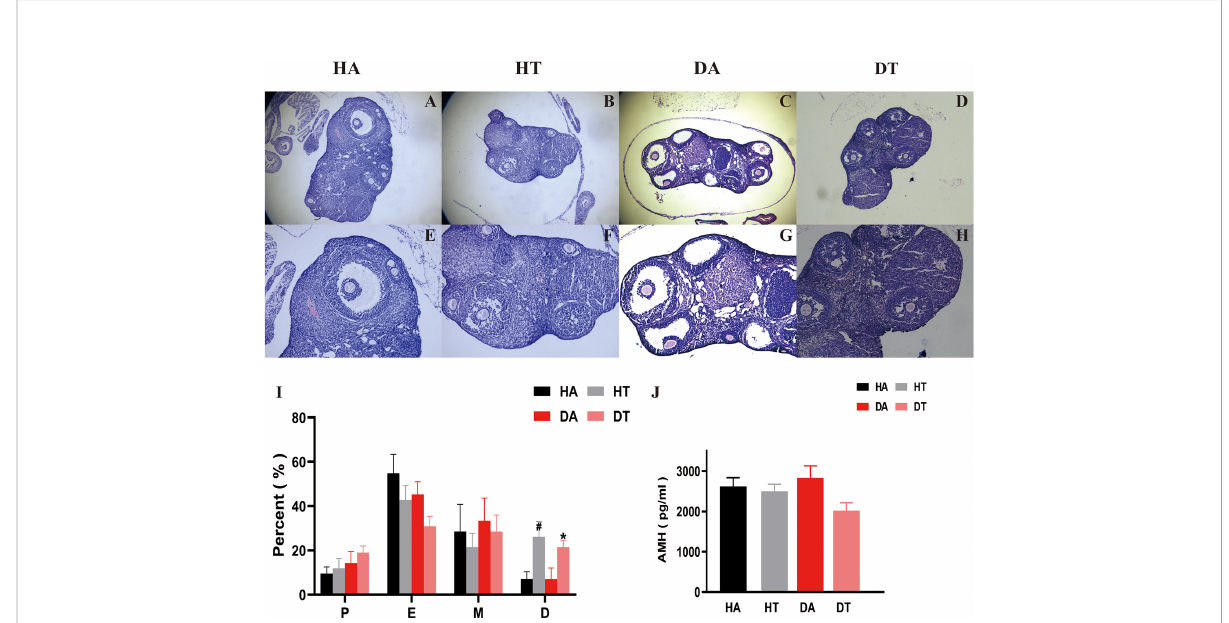
FIGURE 4 TRF ameliorates ovarian dysfunction in PCOS mice. (A-H) Hematoxylin and eosin (H, E) staining of typical sections of mouse ovary, Bar = 500 m m in A, B, C, and D. Bar = 250 m m in (E – H) . (I) Comparison of the percentage of estrous cycle (1 week) in each group 2 weeks after TRF. (J) Plasma anti-Müllerian hormone (AMH) level. *P<0.05, DT group vs. DA group. # P<0.05, HA group vs. HT group. Data were presented as mean ±